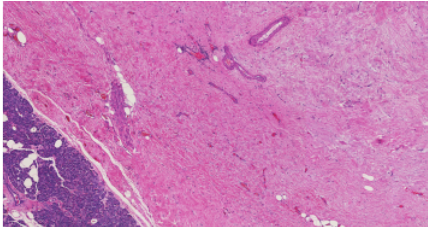
Figure 2: The hypocellular nodules demonstrated abundant col- lagen with nondescript bland spindle cells and occasional small indwelling arteries (H&E, 40x).